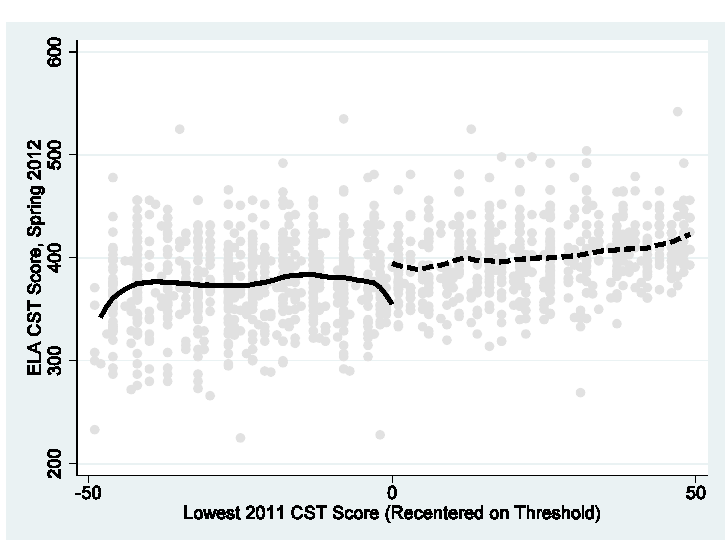
Figure S3: Regression discontinuity analysis of the effect of white card placement on Spring 2012 ELA CST scores, for 2011-12 Live Oak and Mann students (50% of preferred bandwidth: